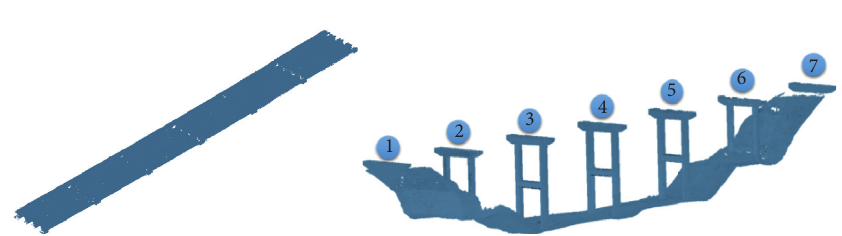
Figure 16: Point clouds of the upper and lower parts of the bridge after